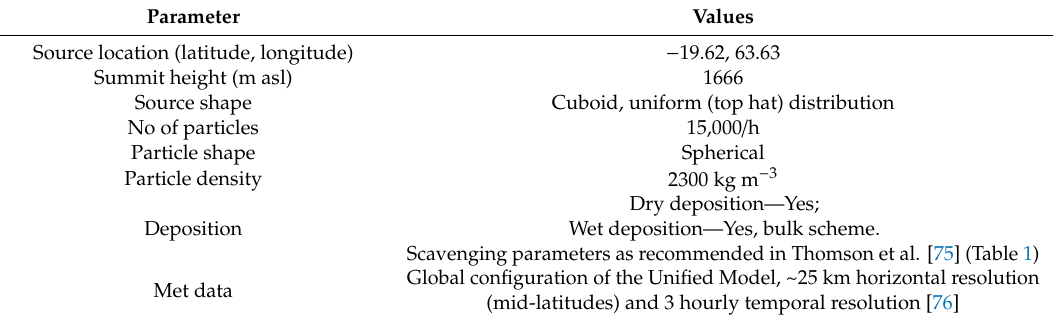
Table 4. Input parameters for NAME